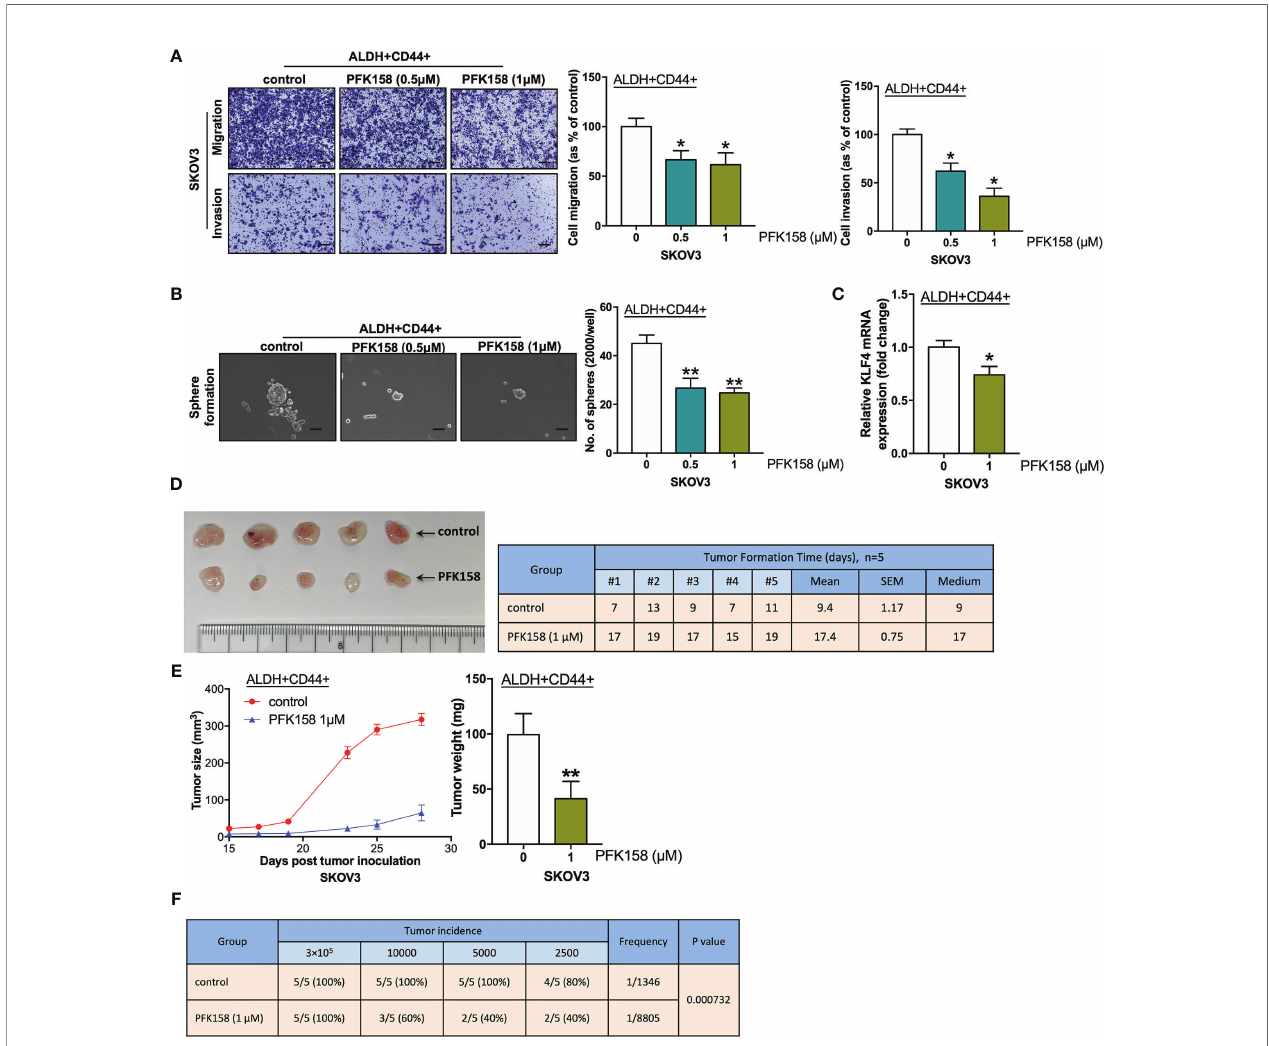
FIGURE 5 | PFK158 suppresses stemness in ovarian cancer. (A) Transwell migration and invasion (scale bar, 100 m M) and (B) sphere formation (scale bar, 100 m M) of ALDH+ CD44+ SKOV3 cells pretreated with control and PFK158 (0.5 and 1.0 m M) for 48 h. (C) Relative KLF4 mRNA expression of ALDH+CD44+ SKOV3 cells treated with 1.0 m M PFK158, determined by qPCR. (n=3; *p < 0.05, **p < 0.01). (D) After inoculation of 3×10 5 ALDH+CD44+ SKOV3 cells pretreated with control (n = 5) and PFK158 (1.0 m M, n = 5) into the right/left fl anks of mice, images of dissected tumors and tumor formation days were recorded. (E) Line chart showing the tumor growth and bar chart showing the weights of tumors derived from the mice injected with 3×10 5 control and PFK158-pretreated ALDH+CD44+ SKOV3 cells. (F) Tumor incidence and estimated frequency from in vivo limiting dilution assays with injection of a limiting dilution (3×10 5 , 10×10 3 , 5×10 3 , or 2.5×10 3 cells) of control and PFK158-pretreated ALDH+CD44+ SKOV3 cells into the fl anks of